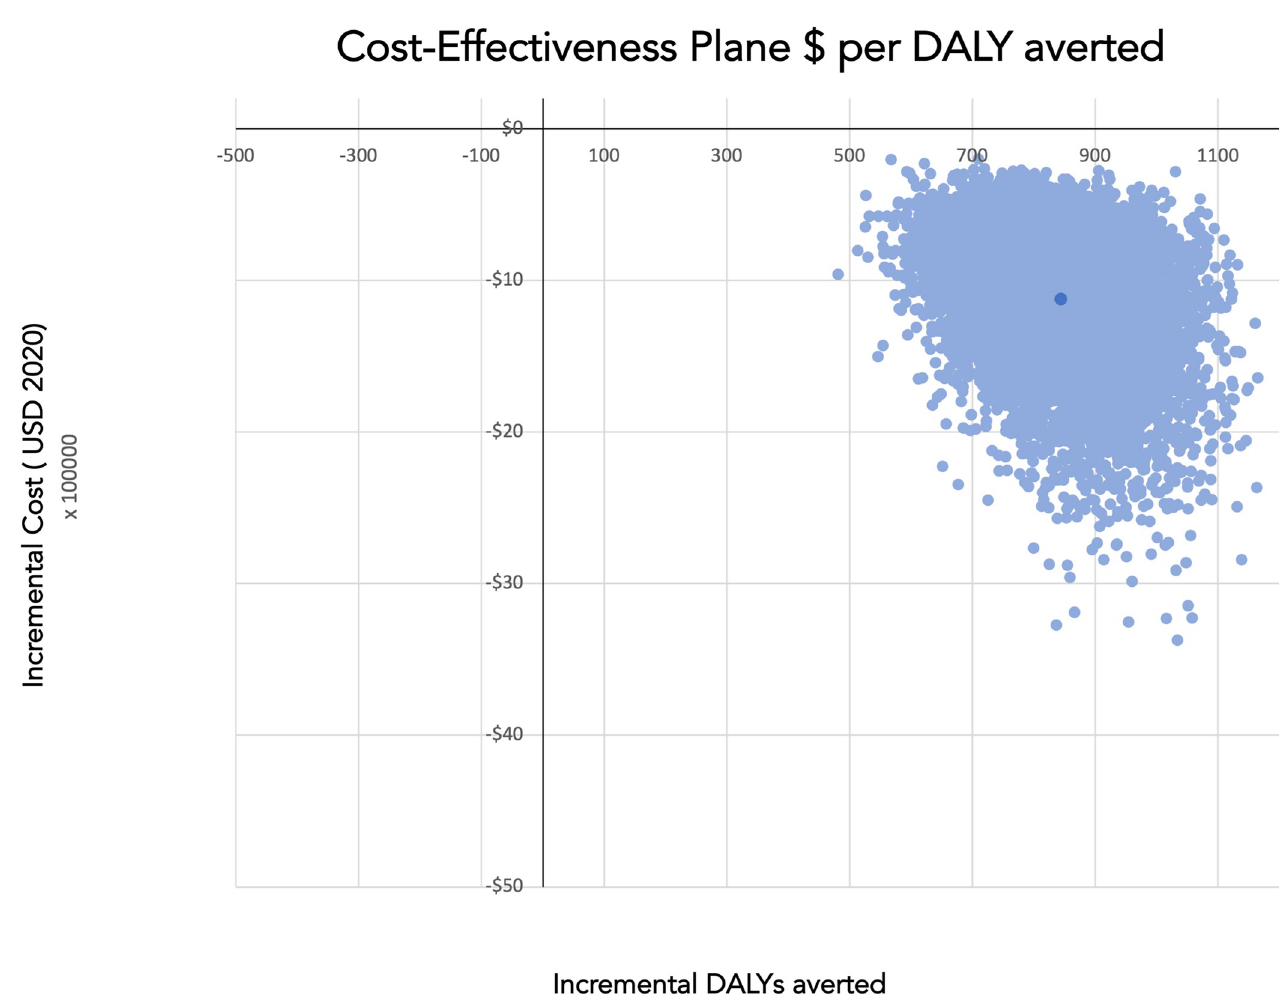
Fig 3. Cost-effectiveness plane results of 10,000